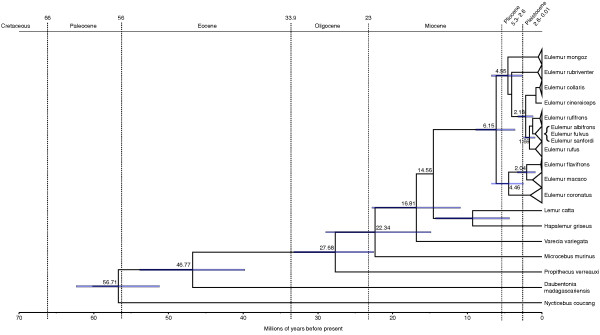
Simplified Bayesian tree of 121 Eulemur individuals and seven outgroups of the cytochrome B with divergence date estimates for well supported nodes. The mean age is given in millions of years and 95% credibility intervals are indicated by blue bars. A geological time scale is shown at the top. Details of divergence date estimates are given in Table 2.